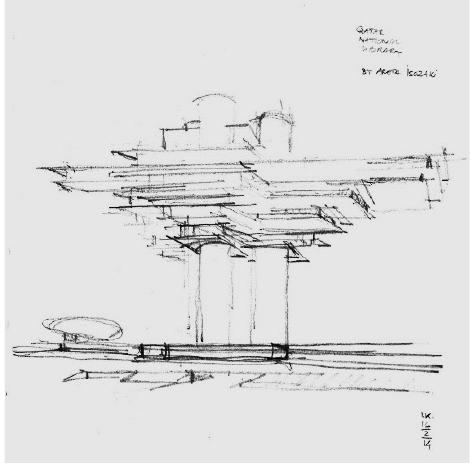
Figure 4. Sketch for the National Library Qatar, 2002. (Sketches courtesy: Arata Isozaki & Associates) .